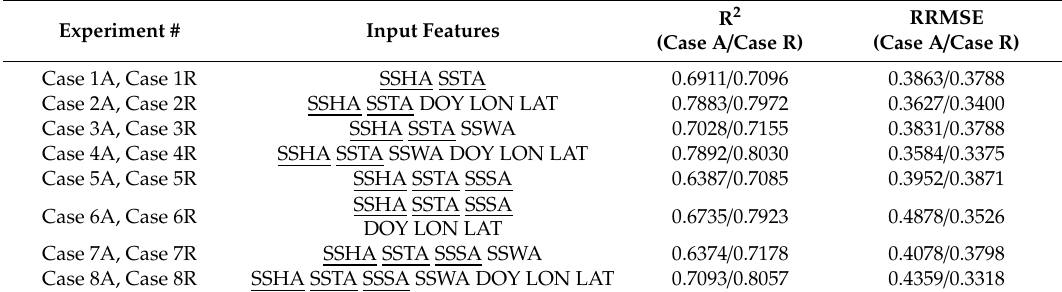
Table 1. Experiments design and results for projecting OHC300